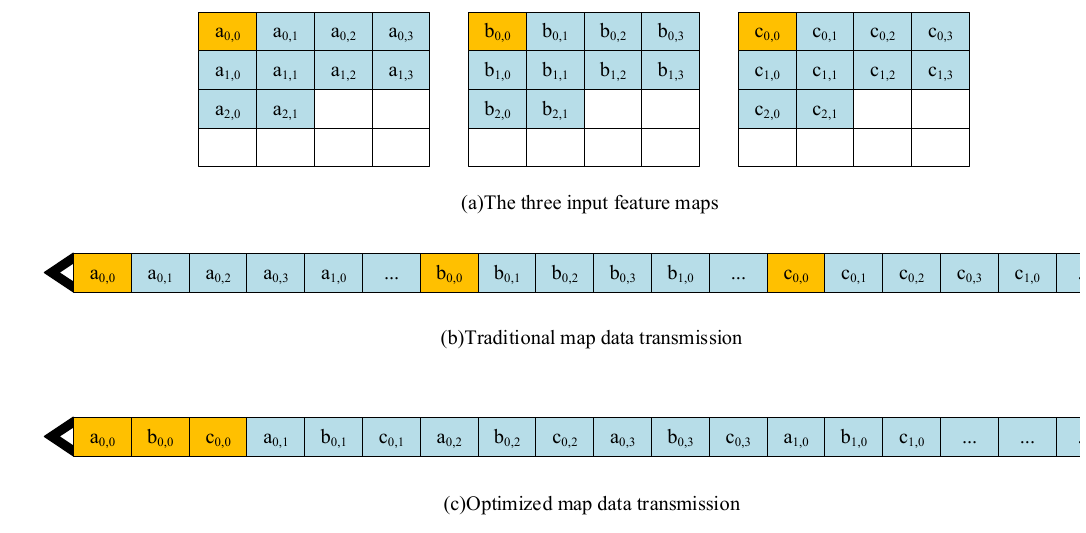
Figure 10. Optimization of map data transmission.